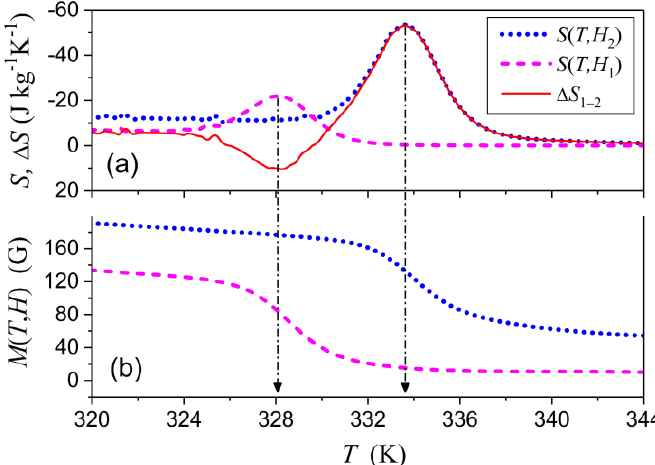
Figure 4. ( a ) Theoretical entropy functions computed for two values of magnetic field and the difference of these functions. ( b ) The fragments of theoretical magnetization curves shown in Figure 3.